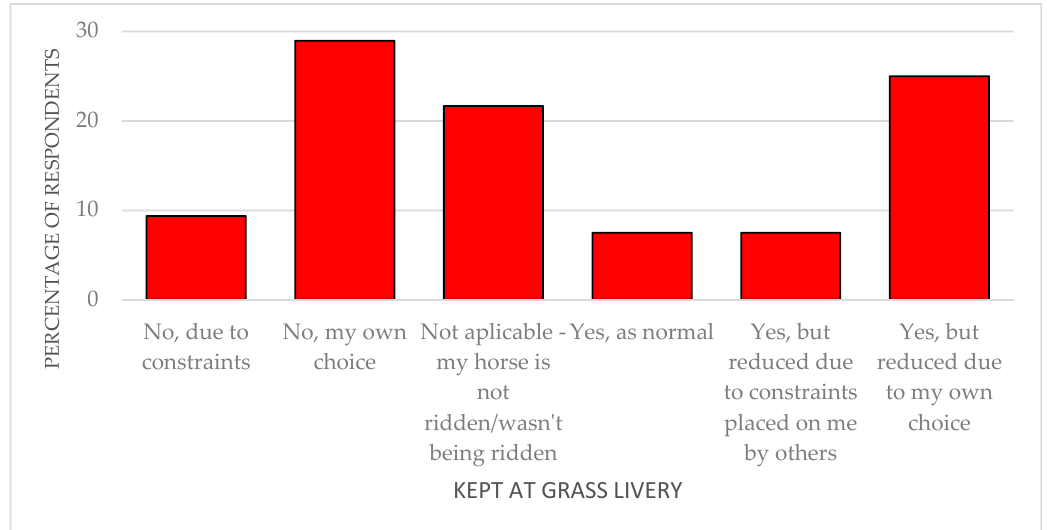
Figure 3. Differences in riding practices by establishment type. Horse owners were asked to select the option that best described how they were riding their horse since restrictions were implemented in response to the COVID-19 pandemic. The data are reported by establishment type.